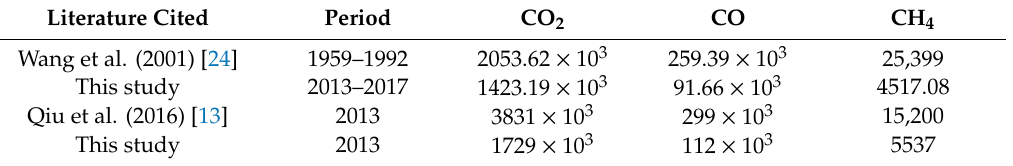
Table 5. Comparison of the emissions with previous estimates at different temporal scales (unit: Mg).